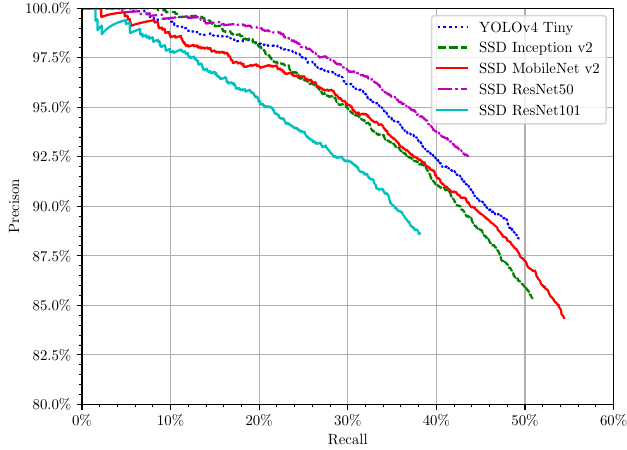
Figure 12. Precision × recall curve in the test set using the calibrated confidence